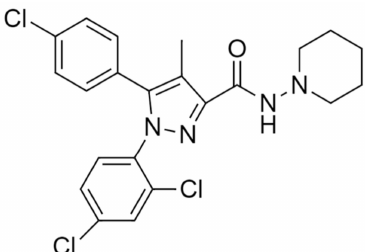
Figure 4. Rimonabant (SR141716A)-Chemical structure of CB1 selective antagonist